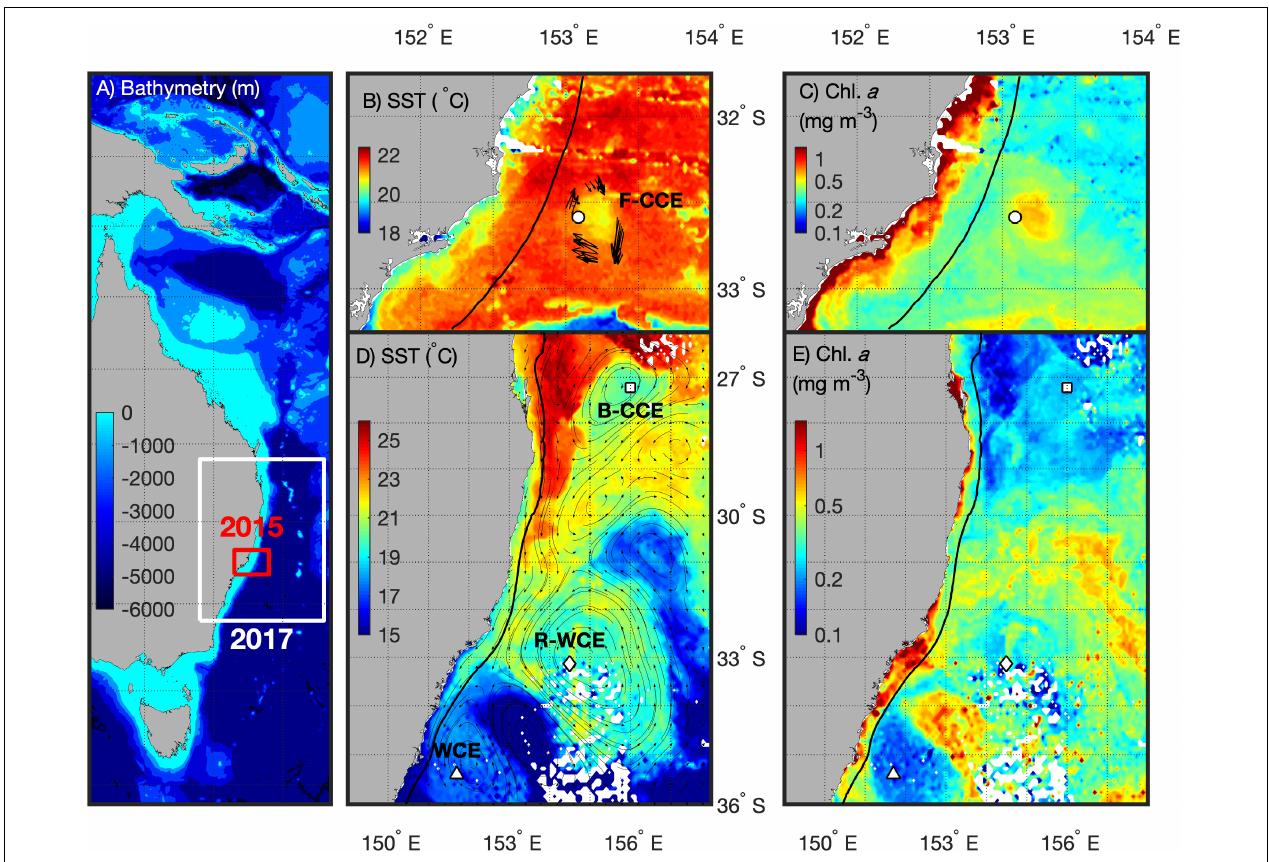
FIGURE 1 | Southeast coast of Australia (A) highlighting the 2015 (red) and 2017 (white) sampling locations with bathymetry overlaid. For 2015 (top) the F-CCE location ( ◦ ) is shown with (B) Sea Surface Temperature (SST) and ADCP data (Roughan et al., 2017), and (C) chlorophyll a (Chl. a ) data from the 8–9 June 2015. For (cid:5) 2017 (bottom) the locations of the B-CCE ( (cid:3) ) , R-WCE ( ) , and WCE ( (cid:49) ) are shown with (D) SST and altimetry data from IMOS, and (B) Chl. a data from the 3–5 September 2017. The black line represents the 200 m shelf (B–E) .